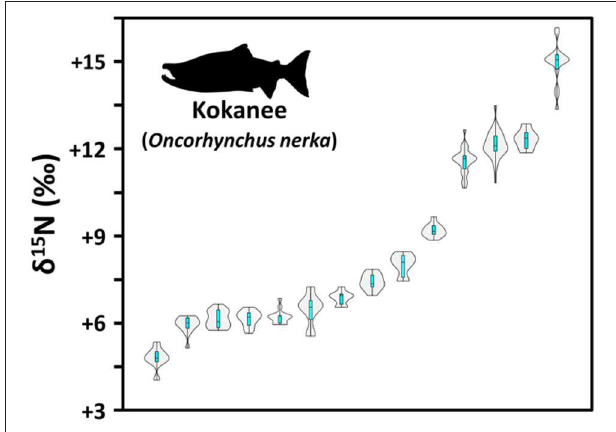
FIGURE 7 | Violin and boxplot showing variation in δ 15 N between modern (1975–2015) kokanee ( Oncorhynchus nerka ) populations from lakes across western North America. Because data are from adults, this variation should broadly reflect environmental conditions rather than trophic level differences. From left to right: Fallen Leaf Lake, CA ( n = 8); Wahleach Lake, BC ( n = 15); Comox, BC ( n = 20); Revelstoke, BC ( n = 15); Alouette Reservoir, BC ( n = 15); Kinbasket Lake, BC ( n = 15); Cowichan Lake, BC ( n = 9); Arrow Lake, BC ( n = 16); Shuswap Lake, BC ( n = 8); Tezzeron Lake, BC ( n = 21); Okanagan Lake, BC ( n = 25); Jo-Jo Lake, AK ( n = 61); Kalamalka Lake, BC (n = 6); Lake Sammamish, WA ( n = 17) (data from Guiry et al., in